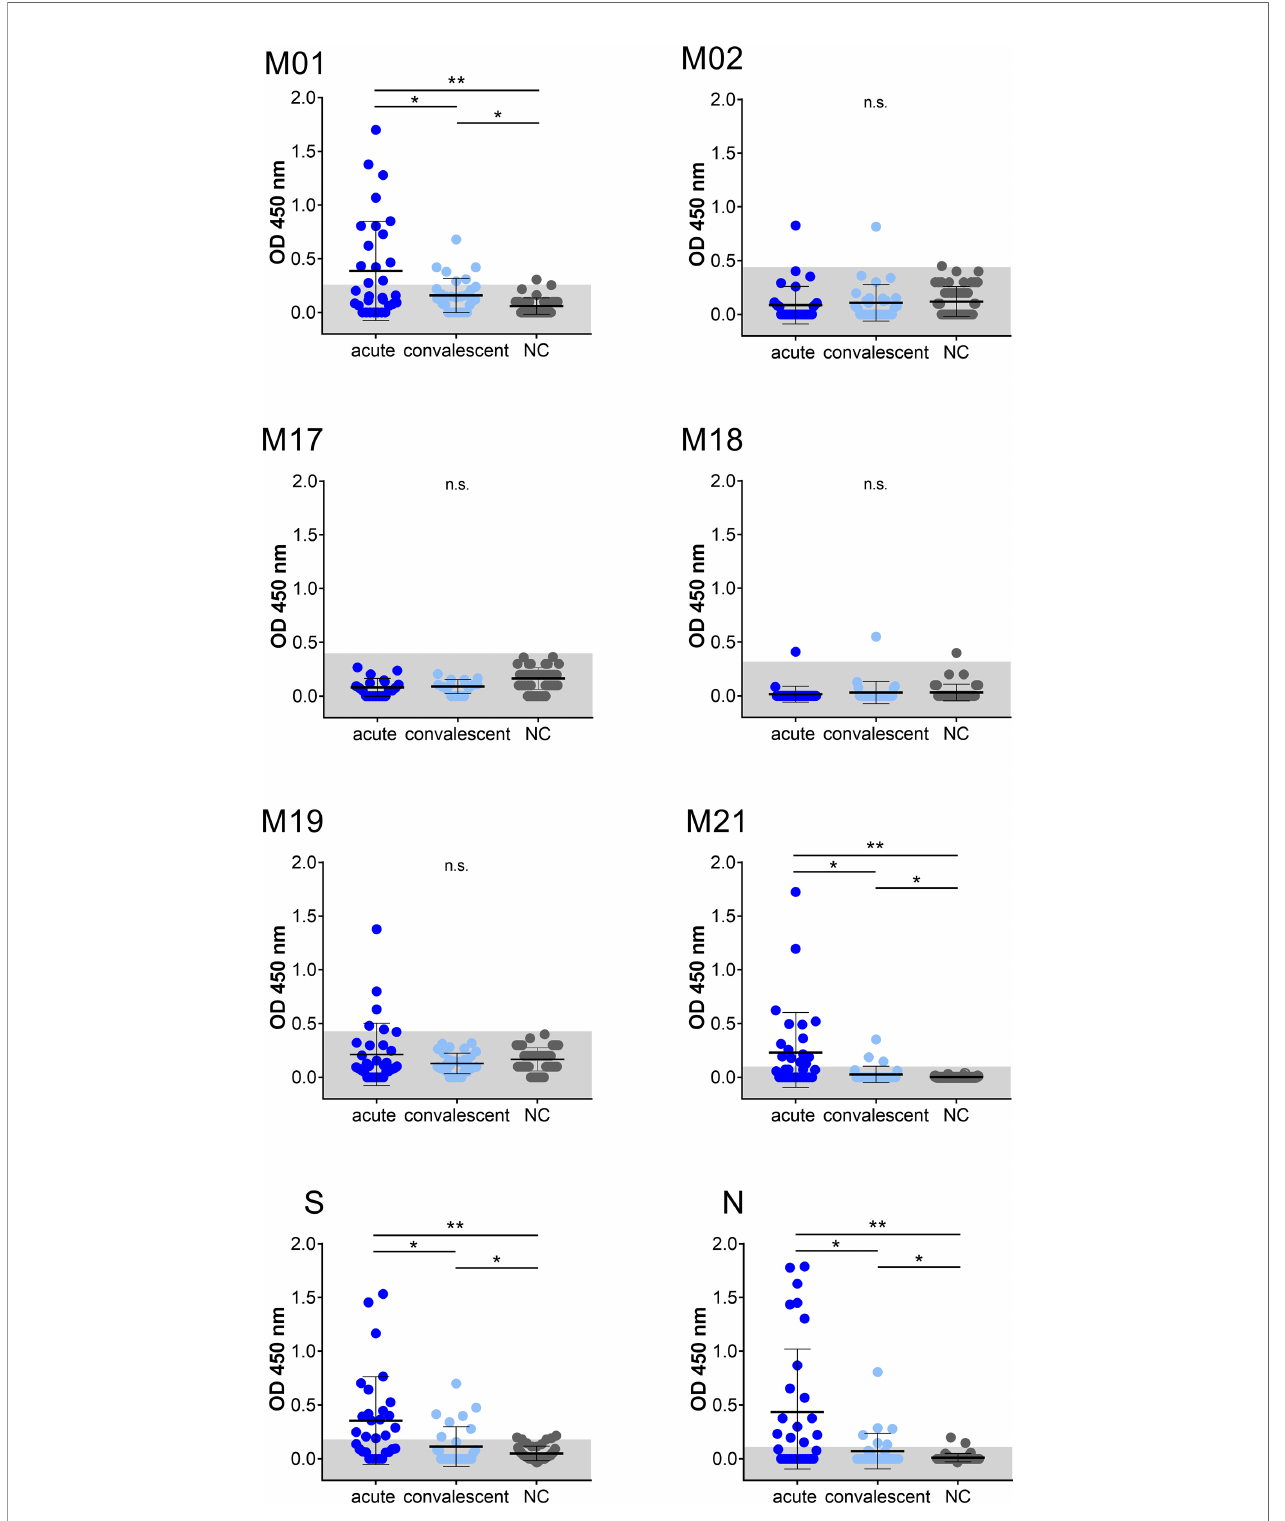
FIGURE 1 | IgG immuno-reactivity obtained with selected peptides of SARS-CoV-2 in two COVID-19 patient cohorts and negative control samples (NC). Each data point represents the OD450 value of one patient. Mean and SD are indicated. The threshold level (mean + 2SD of control) is marked in grey. Data shown is representative of at least 18 independent experiments. Asterisk indicates signi fi cance *P < 0.05, **P < 0.0001. n.s., not signi fi